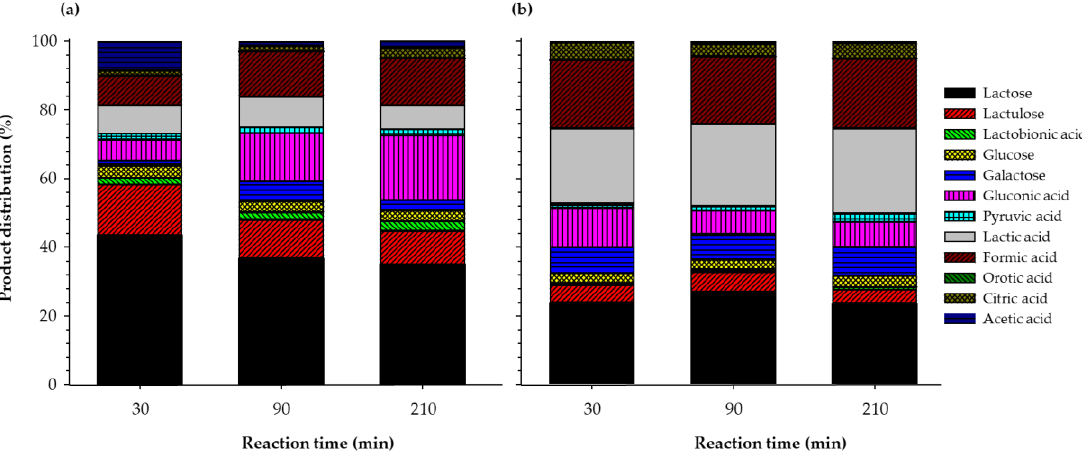
Figure 7. One-pot synthesis of lactose derivatives from ( a ) sweet whey permeate and ( b ) acid whey permeate.